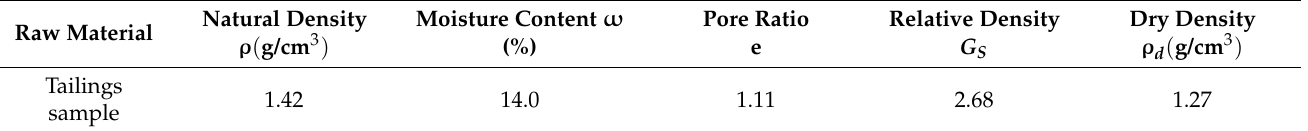
Table 1. Physical properties of the raw tailings sample.